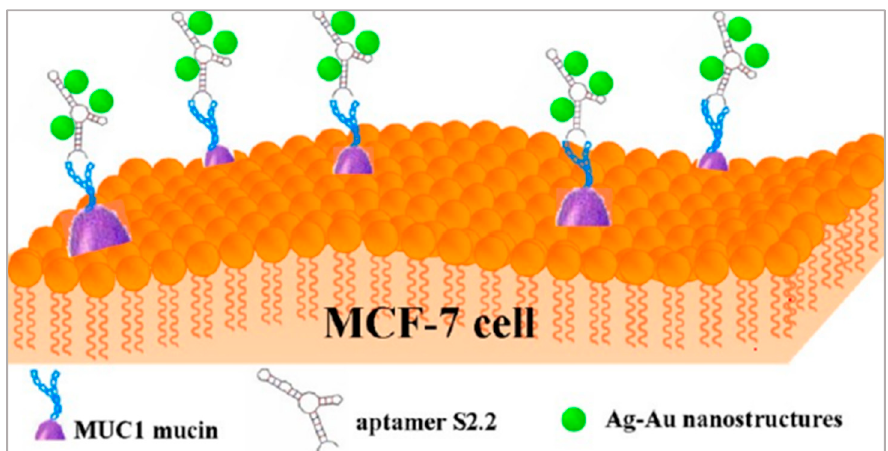
Figure 3. Schematic representation of the preparation of Apt-Ag-Au nanostructure and its application. Reprinted with permission from [79]. Copyright © 2012 American Chemical